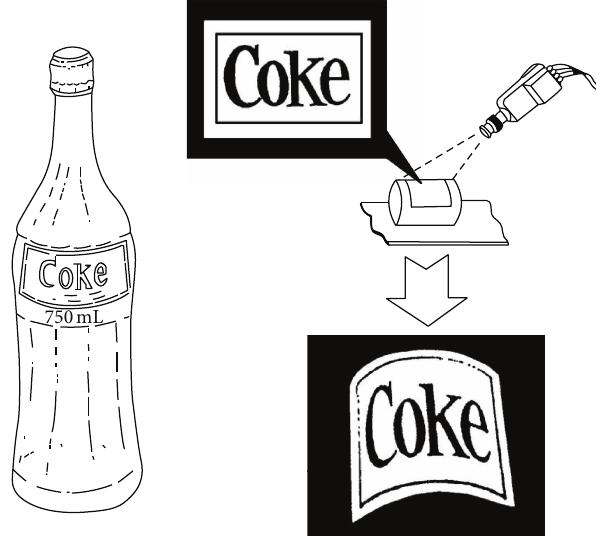
Figure 1: Example of the biquadratic geometric